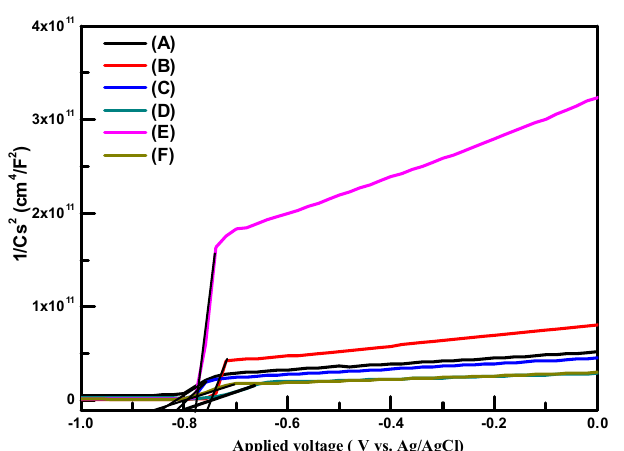
Figure 5. Mott–Schottky plots of samples in the aqueous 0.25 M Na 2 S + 0.35 M K 2 SO 3 solution (pH value of electrolyte = 13.3).